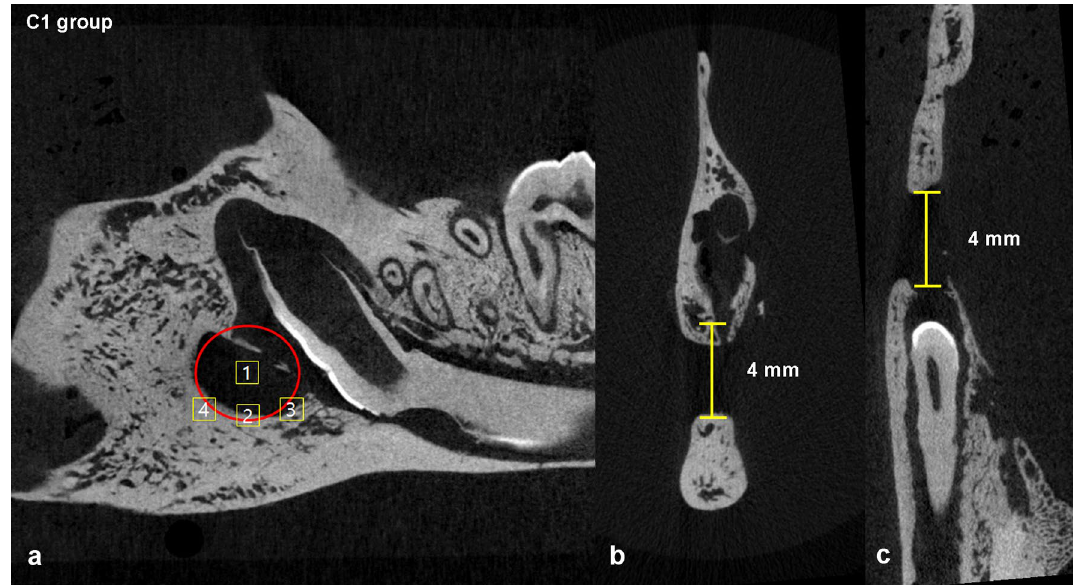
Figure 2. ROI designation method at the round 4 mm defect area. A circular area with a 4 mm wide diameter was first set in the sagittal plane that depicted the defect and four 1 × 1 mm square ROIs were set at the center of the defect and the inferior margins of the circular area ( a ). Axial plane showing bone defects and bone destruction at the buccal surface of the rat mandible ( b ). Coronal view showing the bone defect marked with yellow color ( c